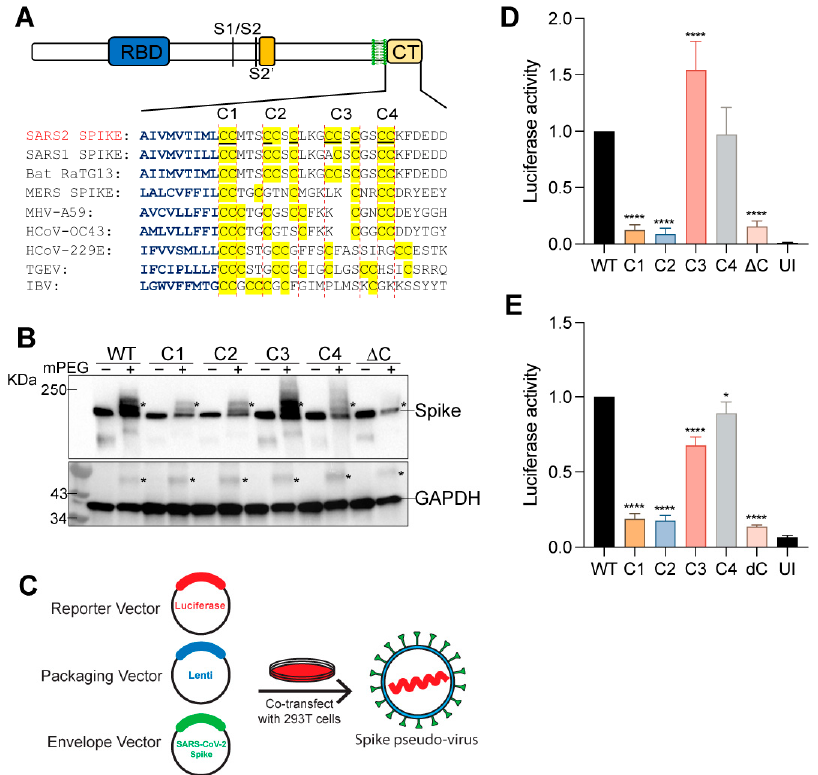
Figure 1. Palmitoylation of SARS-CoV-2 S protein and effect of different cysteine cluster mutations of the S protein on pseudotyped lentivirus infection. ( A ) Sequence alignment of the carboxy-terminal tails of the S protein from the indicated Coronaviruses. The transmembrane region residues are depicted in blue and the conserved cysteine residues in the C-terminal cysteine-rich domain (CRD) are highlighted in yellow. The 10 cysteines of the SARS-CoV-2 S protein (S) CRD were grouped as four clusters—C1 (C1235, 1236), C2 (C1240, C1241, 1243), C3 (C1247, 1248, 1250) and C4 (C1253, 1254). Palmitoylation site prediction algorithm predicted 9 of the 10 underlined cysteine residues as potential sites of palmitoylation (http://csspalm.biocuckoo.org/online.php (accessed on 10